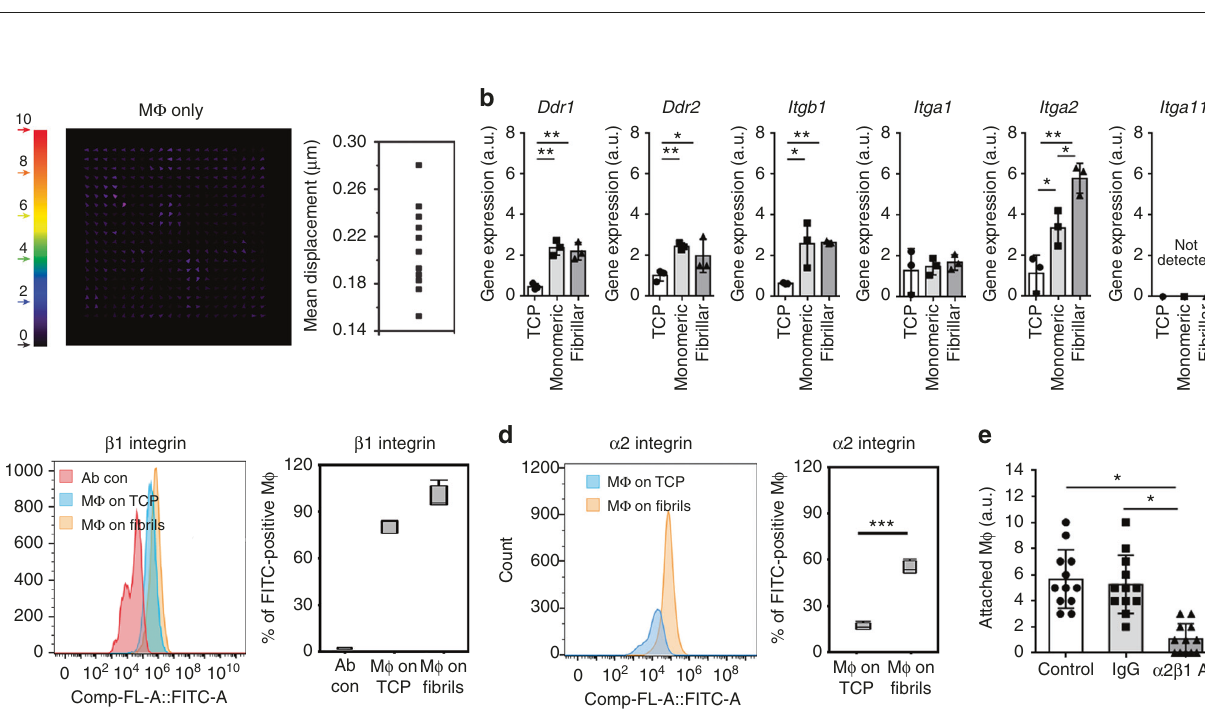
Fig. 6 Macrophages (M ϕ ) detect and respond local displacements in their extracellular matrix (ECM) exceeding a threshold magnitude. a To determine the displacement amplitude change Δ d required to trigger an M ϕ response, M ϕ displacements were co-analyzed with their immediate ECM substrate (marker beads). Only attracted M ϕ with a clear change in behavior from undirected to biased movement toward the myo fi broblast (MF) were included in this detailed analysis (10 M ϕ , 6 independent experiments). Combined Δ d M ϕ and Δ d ECM data were aligned and plotted with respect to the fi rst detectable acceleration in bead/ECM displacement (arrow, t = 0 min). Shown are averages± SD. b Average ECM displacement magnitudes were plotted over 1 – 8 h of MF contraction (Fig. 1f) and analyzed for amplitude changes between time points ( Δ d n ) at any given distance from the MF. c The radii of MF-induced deformation fi elds were measured over time on either 2 mg ml − 1 (blue) or 5 mg ml − 1 (red) collagen gels; averages are shown ±SD ( n = 5). d Marker displacements in collagen gels were used to calculate MF-induced deformation fi elds that are displayed in color-coded vector diagrams with MF position in the center as indicated (red — high displacement). MFs were allowed to pre-remodel the ECM for 8 h (reference point for particle image velocimetric calculations). Deformation was recorded after another 1 h (9 + 1 h) without treatment and 1.5 and 7.5 h after adding lysophosphatidic acid (10 ng ml − 1 ) or phosphate-buffered saline control as indicated. Scale bars: 500 µ m. Graphs show average ECM displacement magnitudes over distance from the MF centroid ( N = 3). e Same experimental set-up as in d but after 1 h pre-remodeling. f Summary three-dimensional plots of the data shown in d , e